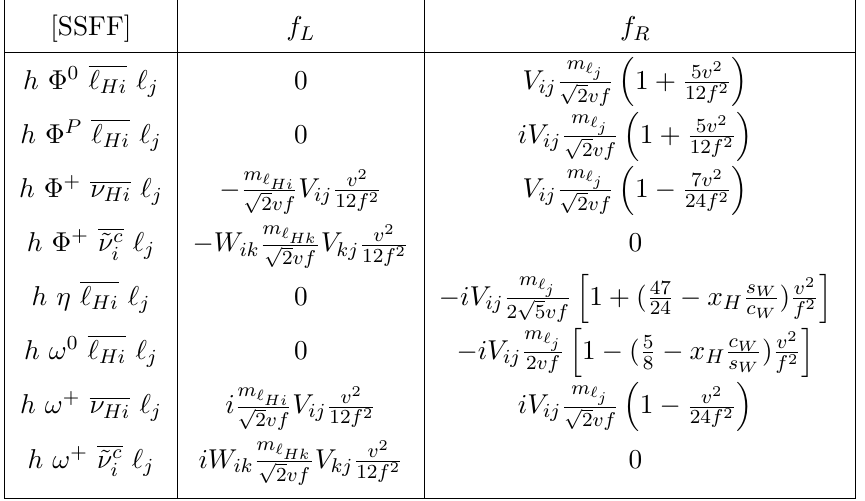
Table 4 . Scalar-Scalar-Fermion-Fermion couplings at O ( v 2 =f 2 ). The corresponding couplings involving the (cid:9) Ri neutral singlet, (cid:31) Ri , do not vanish, but at the order in which we work they do